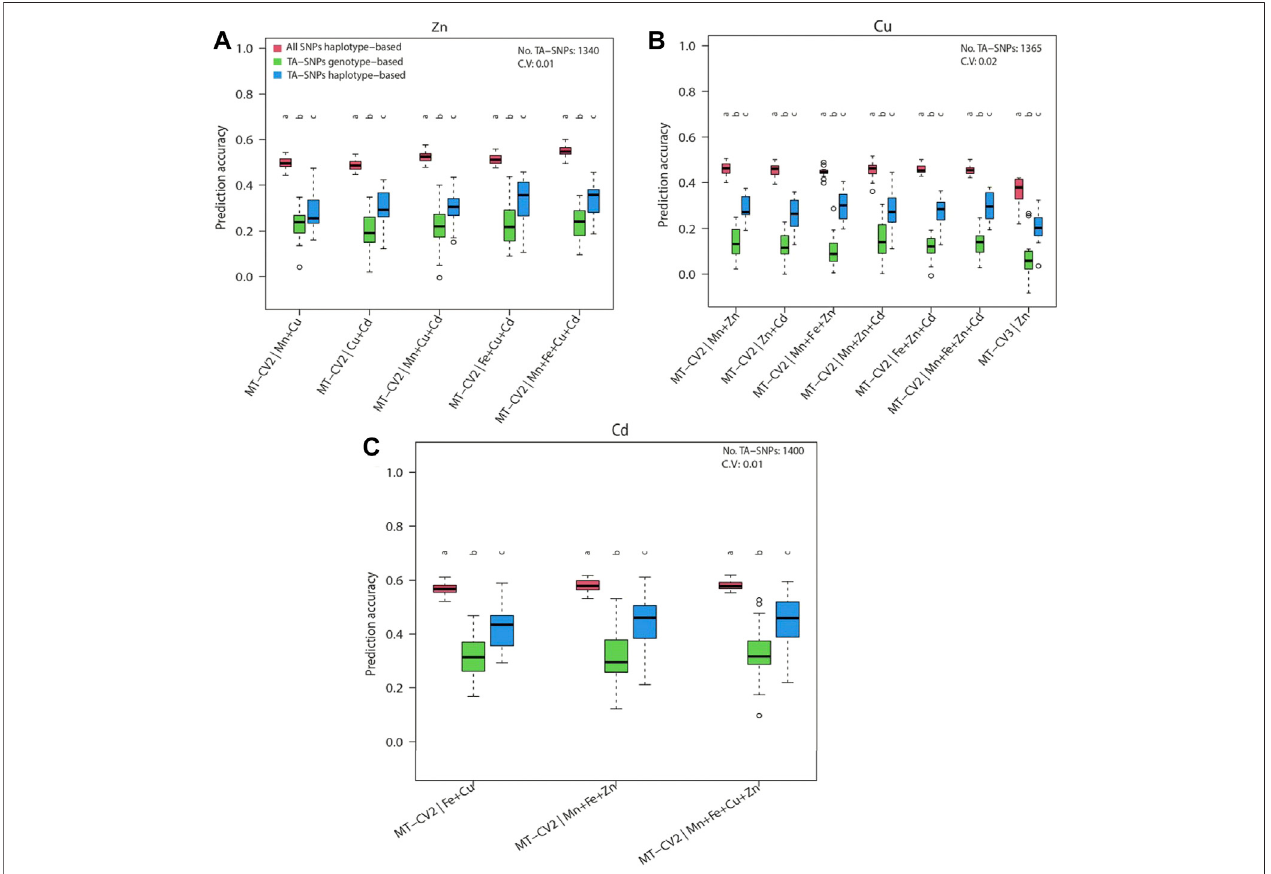
FIGURE7| Genomicpredictionaccuraciesofthehaplotype-basedmulti-traitmodel(MT-UN)withuninformativegenomicmarkers(allSNPshaplotype-based)and haplotype- or genotype-based multi-trait model (MT-UN) with trait-associated SNPs (TA-SNPs) under MT-CV2 and MT-CV3. The target traits were (A) Zn, (B) Cu, and (C) Cd.ThesizeofthehaplotypeblockscontainingtheTA-SNPsismaximally300 kb.Differentlettersaboveboxwhiskersindicatestatisticallysigni fi cant( p < 0.05, t -test) differences among compared groups. The average number and the coef fi cient of variation (CV) of the used TA-SNPs for the observed predictions are shown for each